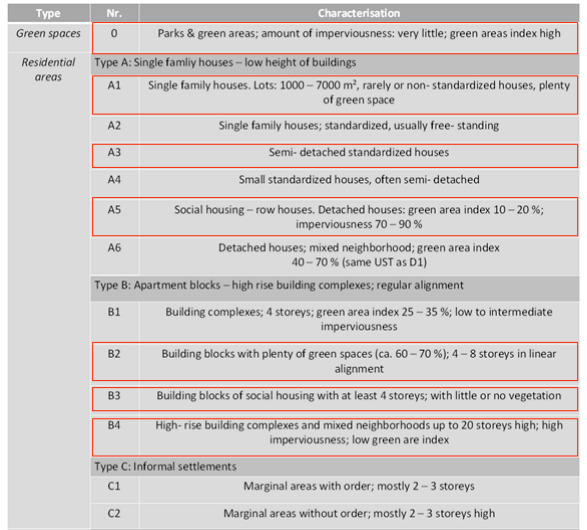
Figure 1. Location of case study within Santiago de Chile Figure 2. Outline of defined UST in Santiago de Chile (after